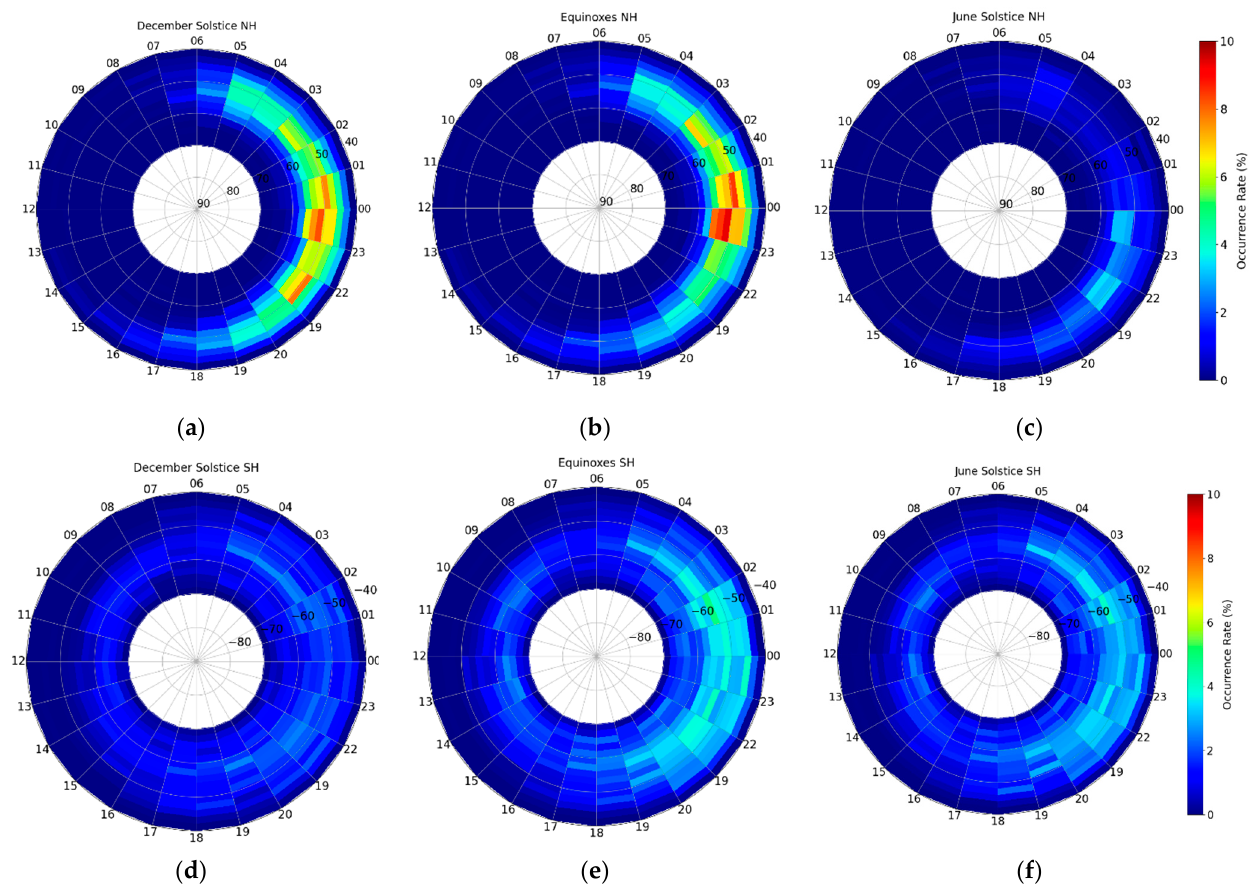
Figure 12. Polar view of the northern ( a – c ) and southern ( d – f ) hemisphere trough occurrence rates in the magnetic local time and magnetic latitude for three seasons: December solstice, June solstice, and equinoxes.